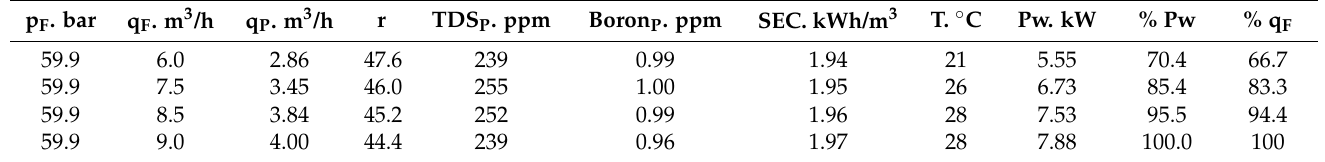
Table 3. Working conditions of a single pressure vessel combining two membrane models (2 LG SW 440 SR and 5 LG SW 440 R) operated at a constant pressure under Mediterranean conditions at an unfavorable